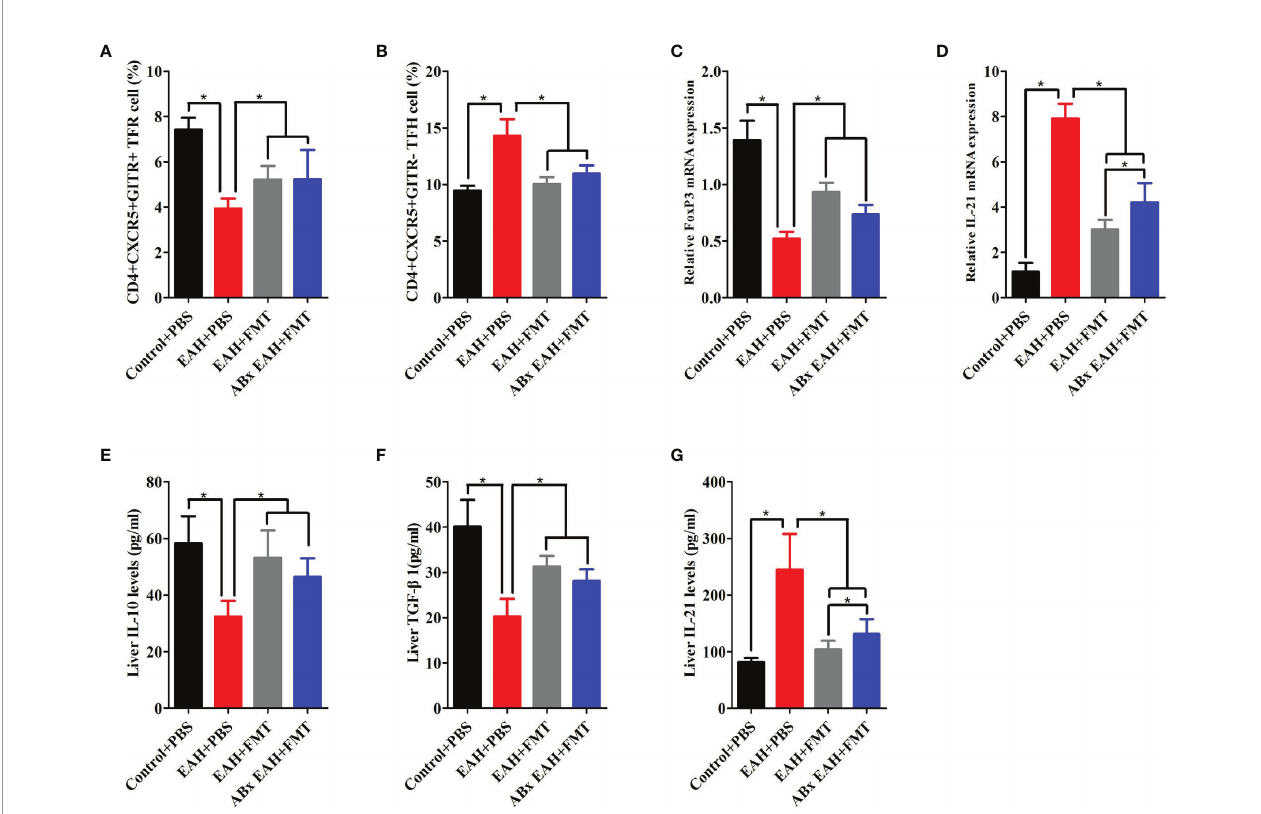
FIGURE 4 | FMT-regulated TFR/TFH cell imbalances. Fifteen mice ( fi ve from the EAH group, fi ve from the ABxEAH group, and fi ve from the control group) were killed at each time point (1, 7, 14, and 28 days) after therapeutic FMT. (A, B) Percentages of TFR and TFH cells in SMNCs on the 28th day were analyzed. (C, D) The mRNA levels of FoxP3 and IL-21 on the 28th day were analyzed. (E – G) Liver IL-10, TGF- b , and IL-21 levels on the 28th day were analyzed. The horizontal lines indicate the mean values of the different groups. *p < 0.05.